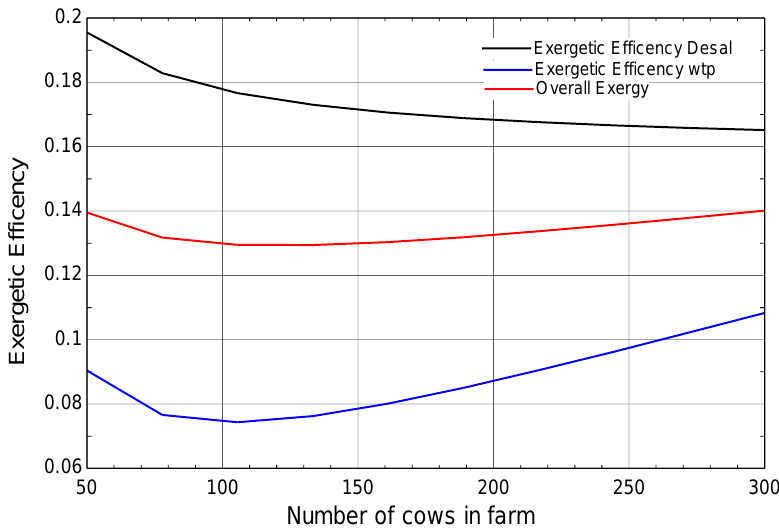
Figure 12. Effect of number of cows on exergetic efficiency of the desalination plant, water-treatment plant, and overall exergetic efficiency.